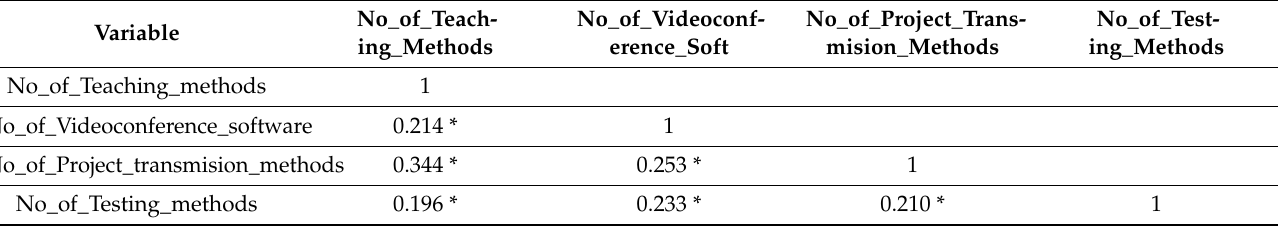
Table 24. Correlations matrix of major variables for main parameters of the online teaching